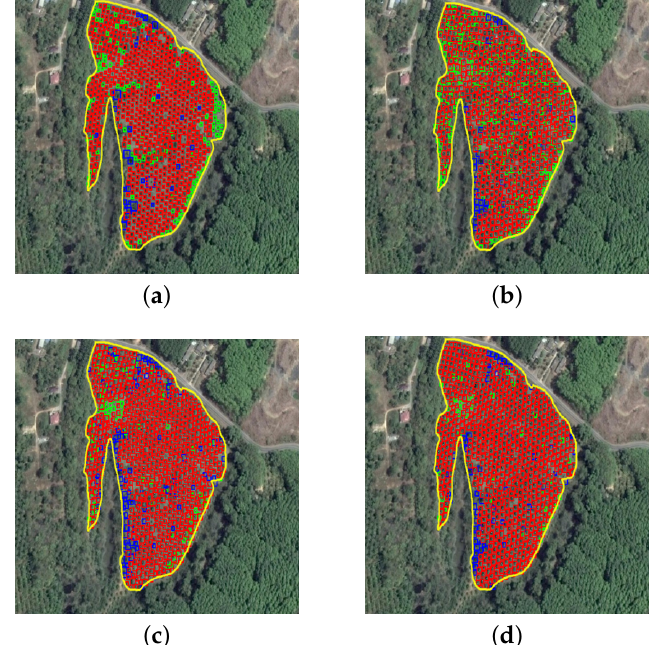
Figure 10. Results of different methods in Test Area 1: ( a ) Region-growing; ( b ) Template-matching; ( c ) Convolutional neural network; and ( d ) Progressive cascaded convolutional neural network.